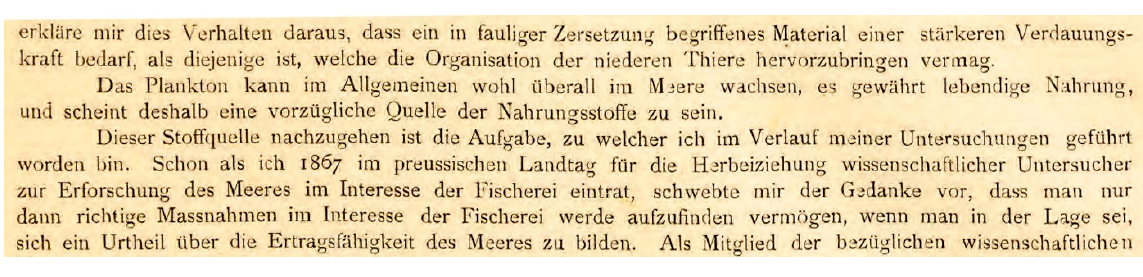
Figure 2. Excerpt from Hensen (1887). The small paragraph translates as: “Plankton can in principle grow all over in the oceans. It constitutes live food and therefore is a great source of nutrition”.